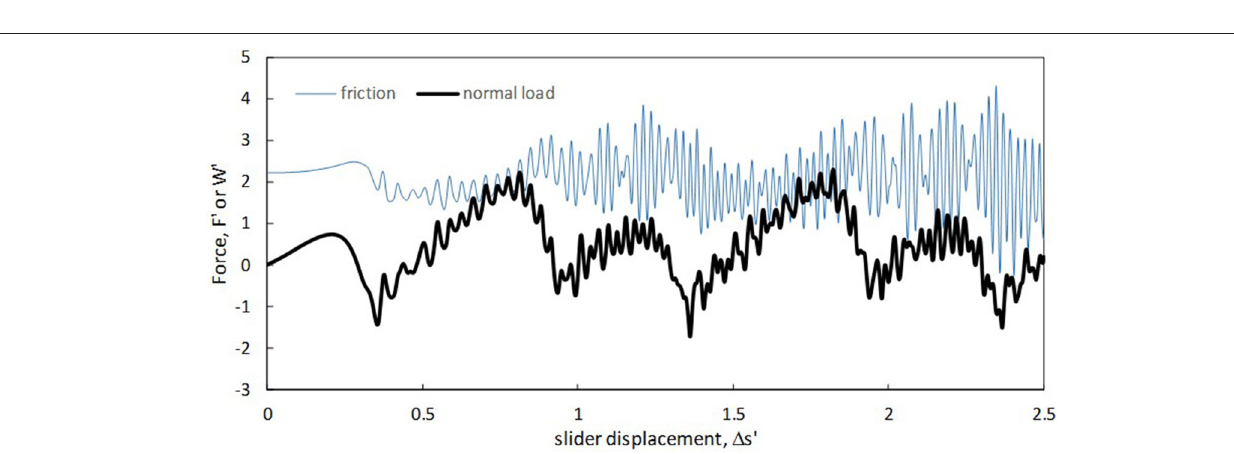
FIGURE 3 | Time histories of friction and normal load for the case of a 5